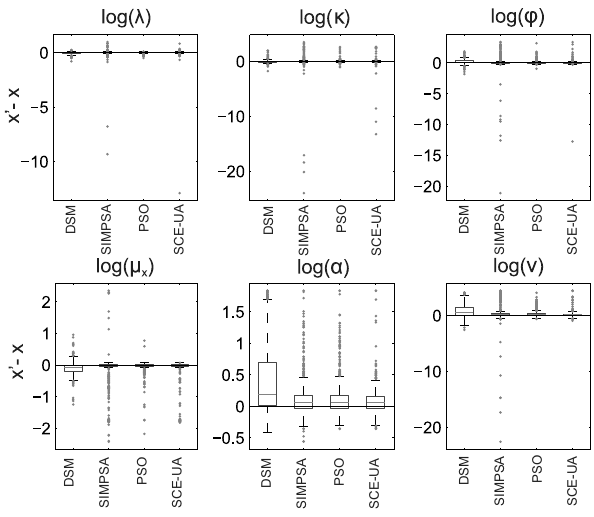
Fig. 6: Distributions of estimation error for each parameter, grouped according to the used optimization method. Fig. 6. Box plots comparing calibration results of DSM, SIMPSA, PSO and SCE-UA. All months and repetitions are lumped together, no averages have been taken.